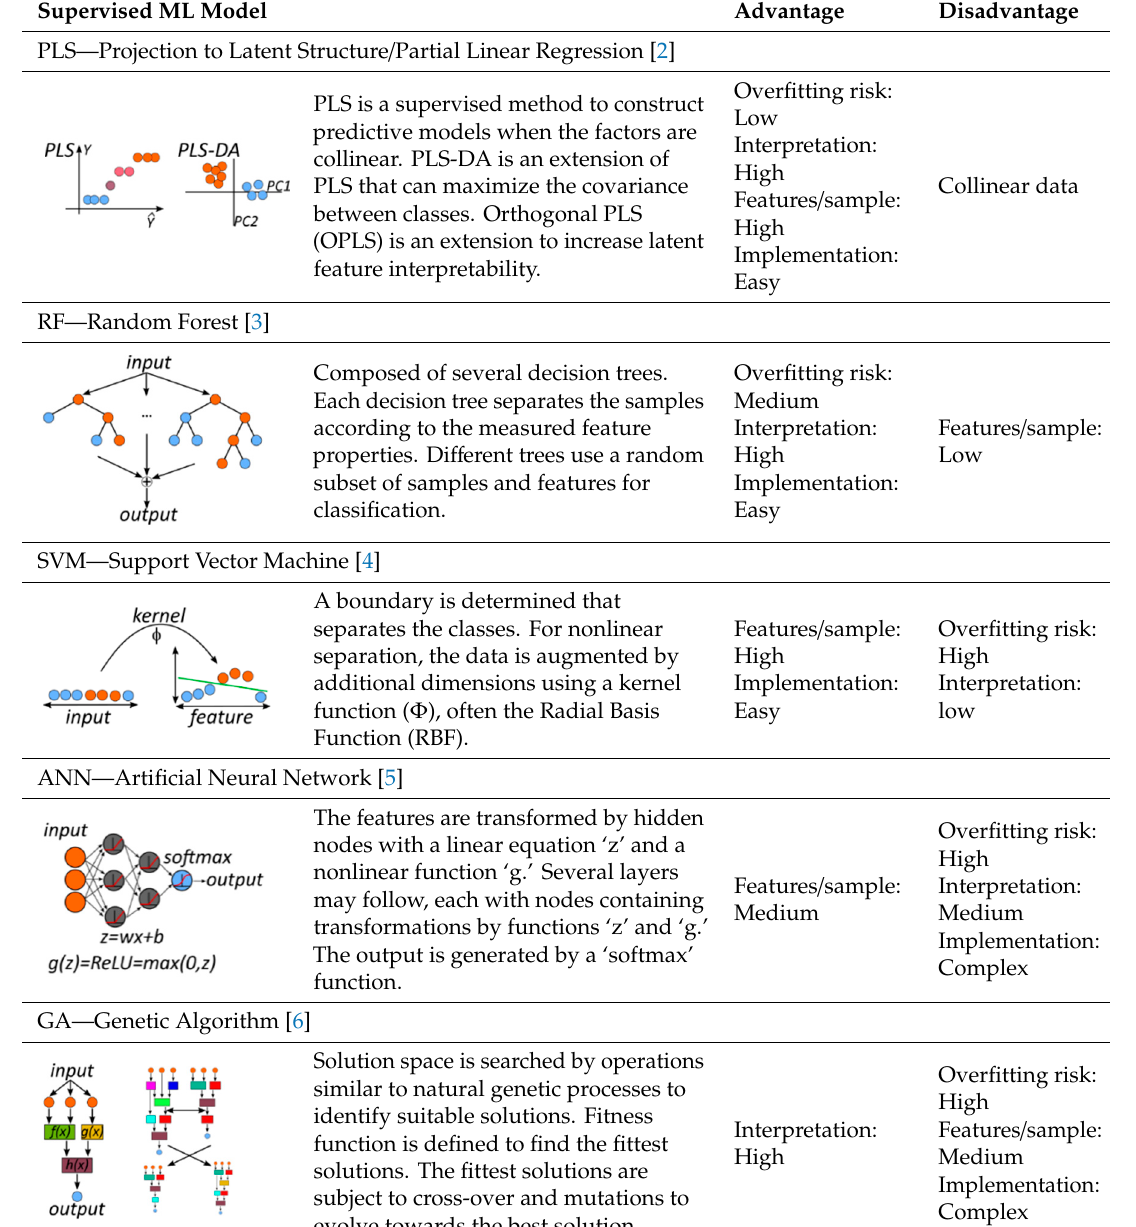
Table 1. Description of important supervised statistical models.